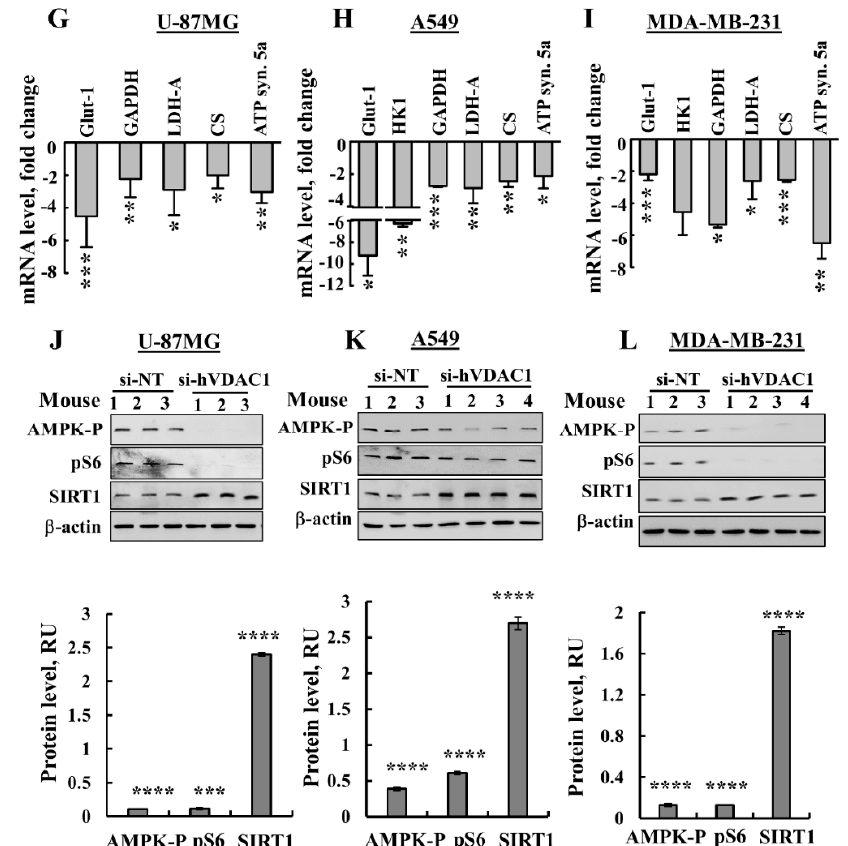
Figure 3. si-hVDAC1 treatment reverses the reprogrammed metabolism of U-87MG-, A549-